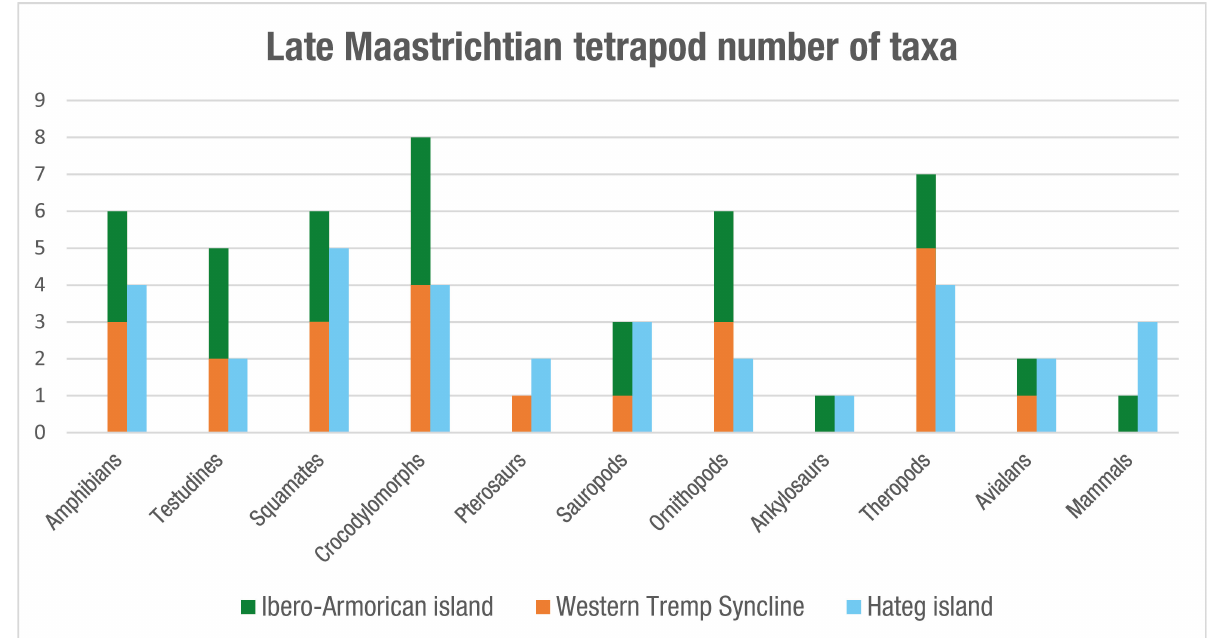
Figure 7. Bar chart with the minimum number of tetrapod taxa (genera) present in the Ibero-Armorican island and Ha¸teg island during the late